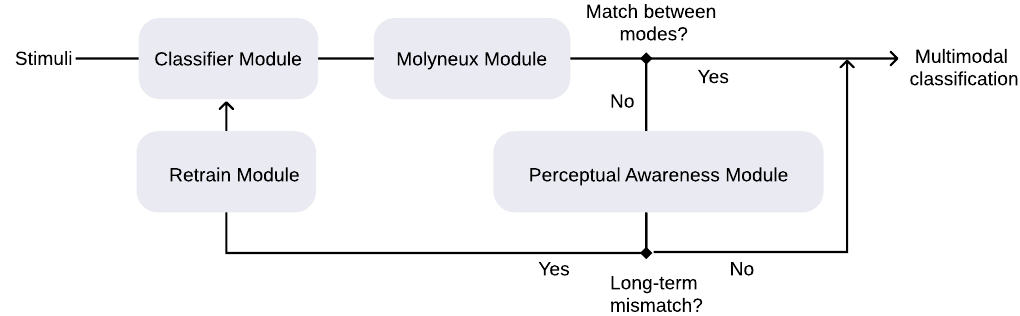
Figure 1. Flow chart of the overall algorithm. Synchronized stimuli (visual and haptic) are classified in the Classifier Module using well-known state-of-the-art algorithms: a CNN classifier for the visual data and a naïve Bayes classifier for the haptic data. Then, the Molyneux Module checks the coherence of the result of the classification of both modes. If the haptic classification and the visual classification match, we say the system is coherent. Otherwise, it must be verified if the incoherence is due to a transient error in a classifier or it persists over time. The Perceptual Awareness Module handles this issue. In the case of a long-term mismatch, the faulty channel is retrained with the relabeled data from the stable channel in the Retrain